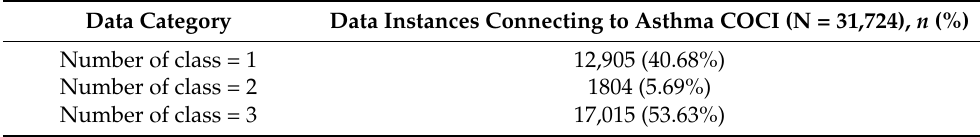
Table 3. The distributions of the COCI category and the data instances between 2011 to 2018.